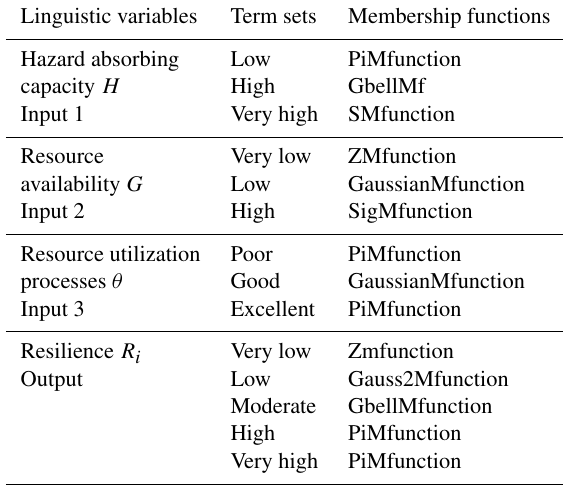
Table 2. Fuzzy inference linguistic variables term sets and mem- bership functions (Adnan et al., 2015; Oladokun and Emmanuel,